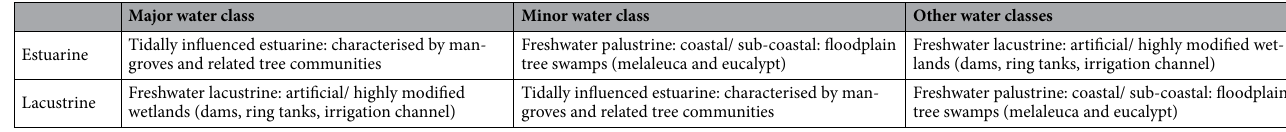
Table 1. Summary of major and minor water body classes present in each surveyed environment.